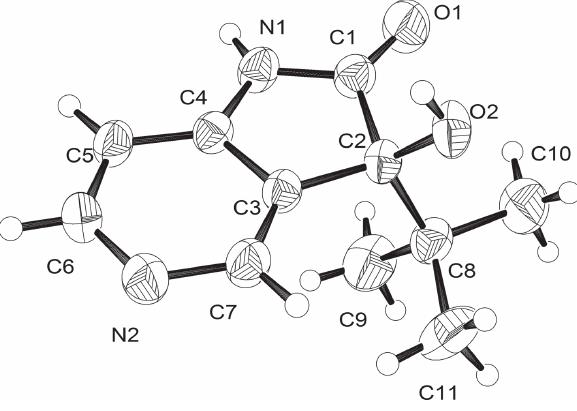
Table 2: Fractional atomic coordinates and isotropic or